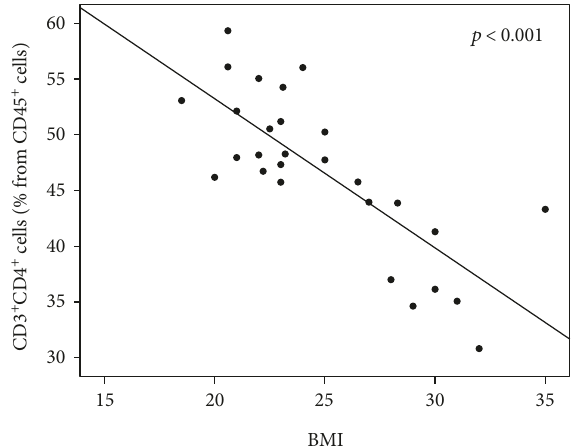
Figure 9: The inverse relationship between CD3 + CD4 + cells (% from CD45 + cells) and BMI. Patients with higher BMI had signi fi cantly lower numbers of CD3 + CD4 + cells (shown as % from CD45 + cells). p < 0 001 , R = − 0 65